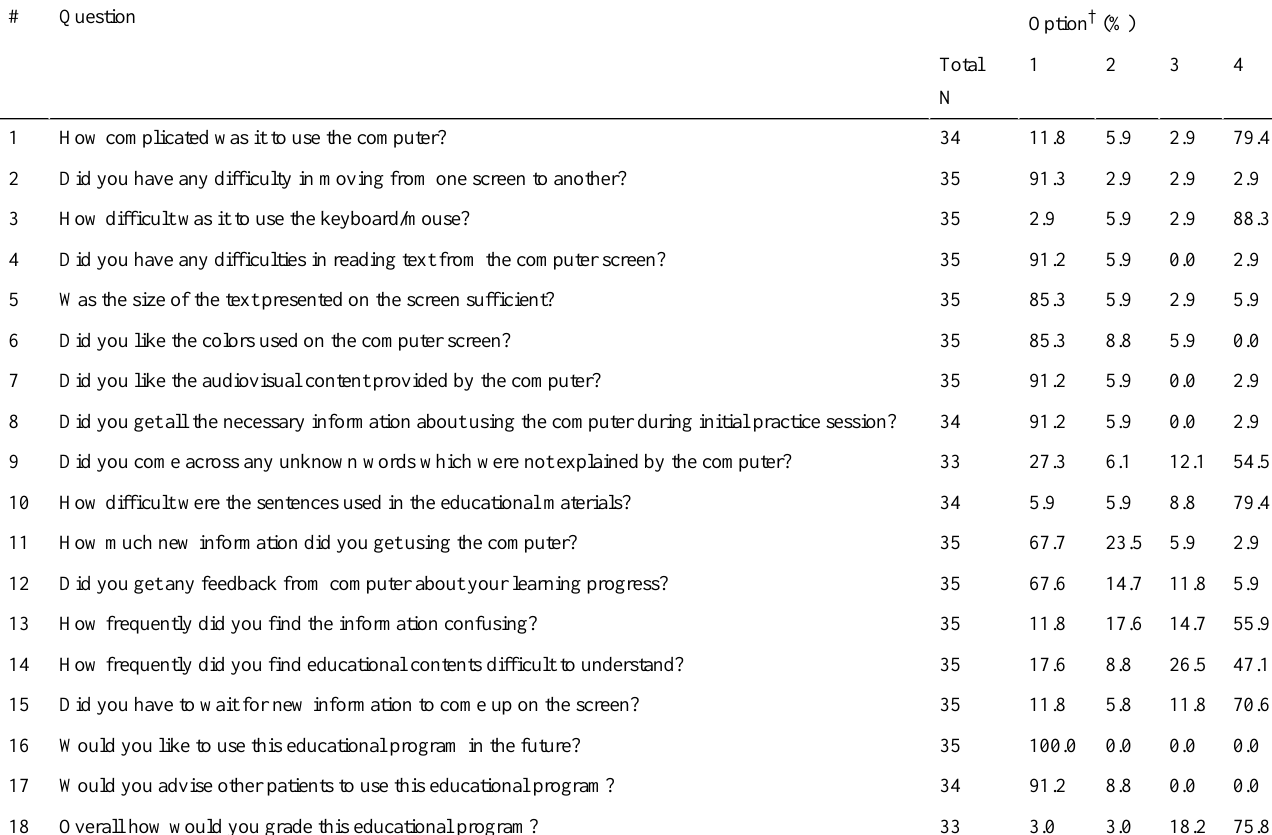
Table 5. Patient satisfaction and attitudes toward different aspects of their educational experience according to the attitudinal